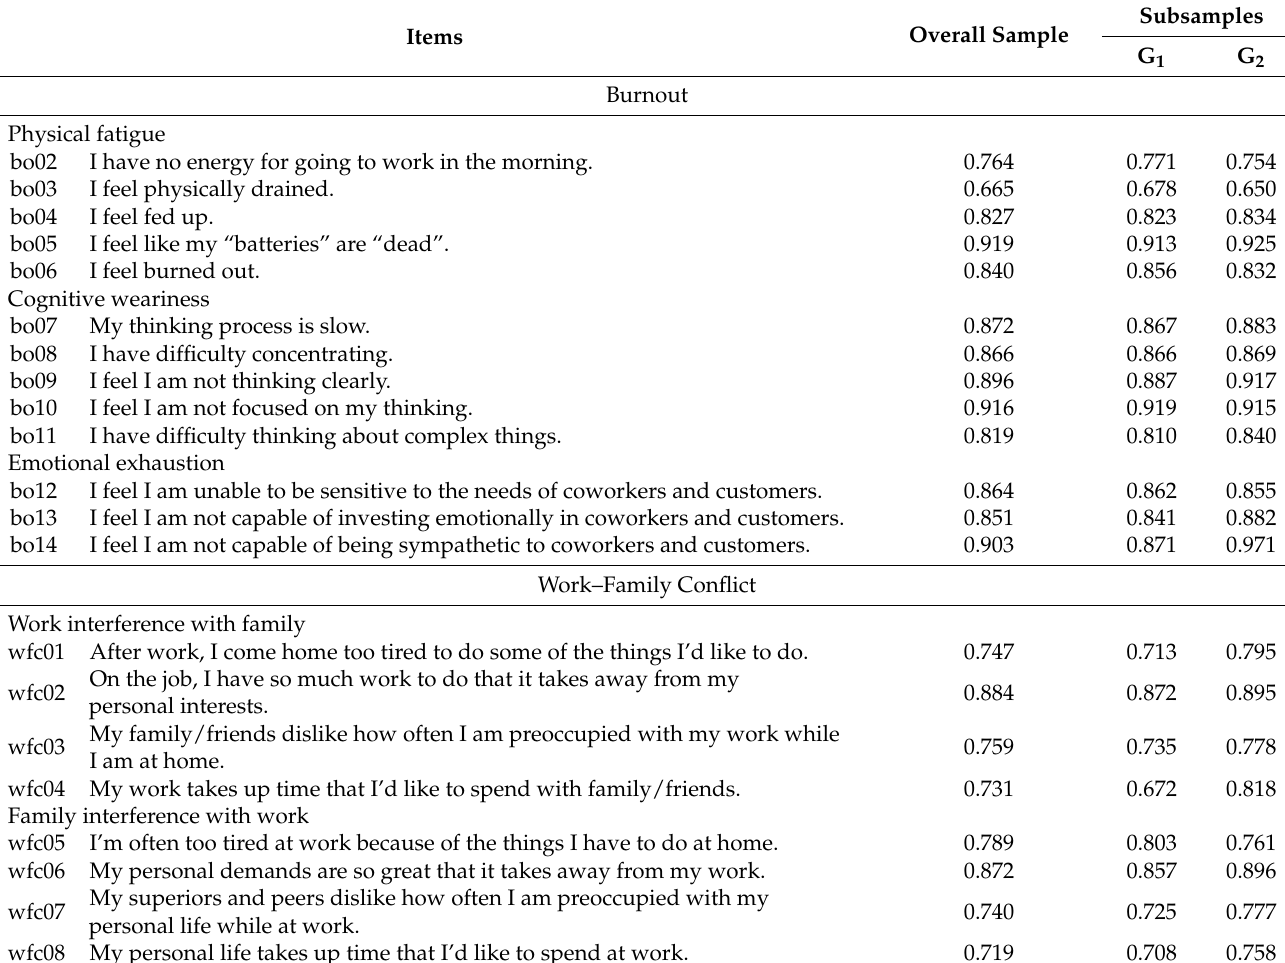
Table 2. Standardized factor loadings from confirmatory factor analyses for burnout and work–family conflict.